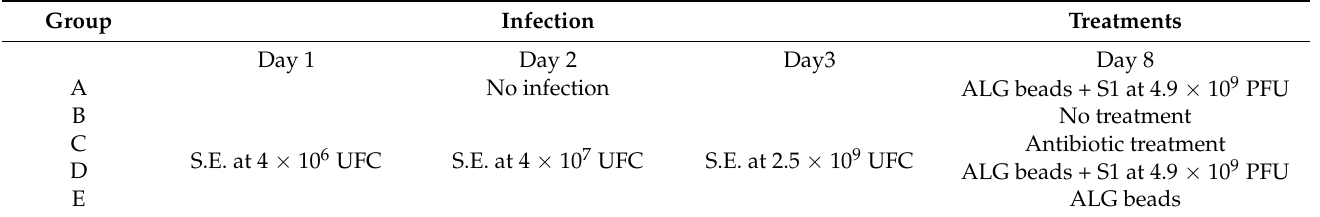
Table 1. Infection registration and types of treatments in each experimental